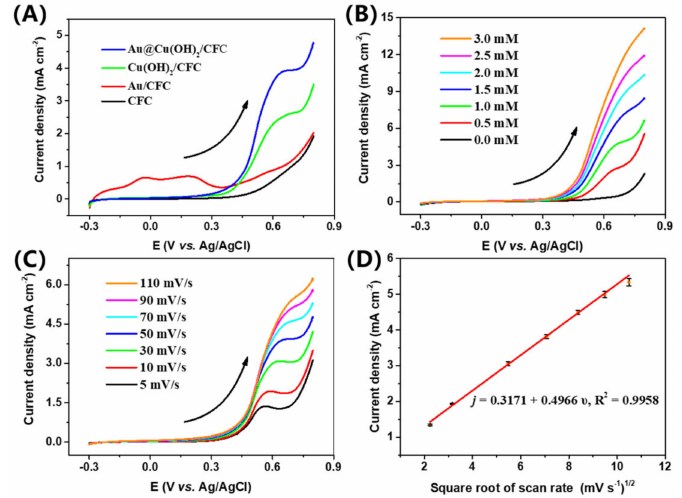
Figure 4. ( A ) Linear sweep voltammetry (LSV) curves of the bare CFC, Au / CFC, Cu(OH) 2 / CFC,